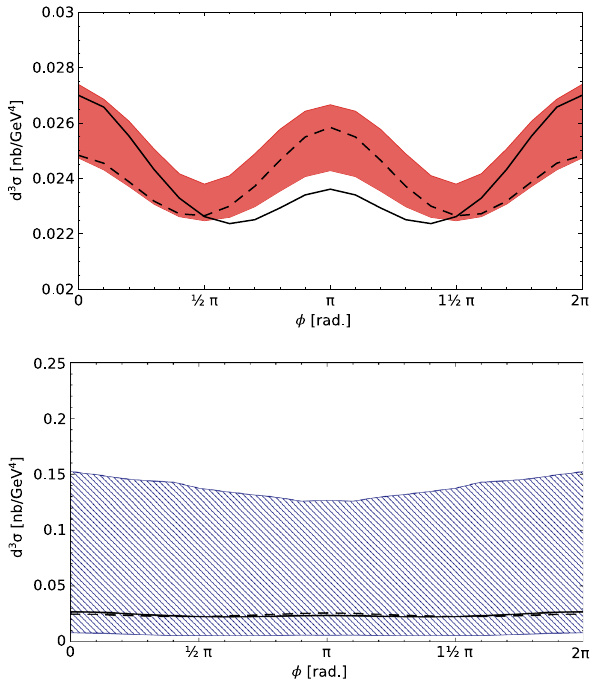
Fig. 4 Differential cross section of the photoproduction of lepton pairs (including TCS and BH processes) integrated over θ ∈ (π/ 4 , 3 π/ 4 ) for Q (cid:4) 2 = 4 GeV 2 , t = − 0 . 1 GeV 2 and the photon beam energy E γ = 10 GeV as a function of the angle φ . In the upper (lower) panel the data-driven predictions evaluated using LO (NLO) spacelike-to- timelike relations are shown. The dashed (solid) lines correspond to the GK GPD model [34–36] evaluated with LO (NLO) TCS coefficient functions (the curves are the same in both panels). Note the different scales for the upper and lower panels. For the further description see the caption of Fig. 2